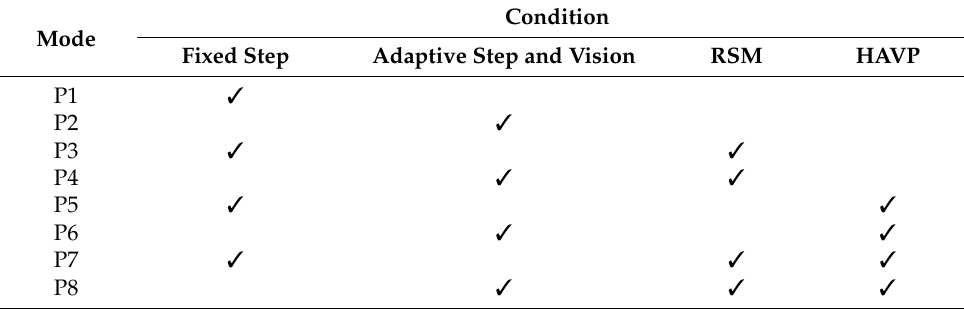
Table 4. Analysis modes for target positioning method.